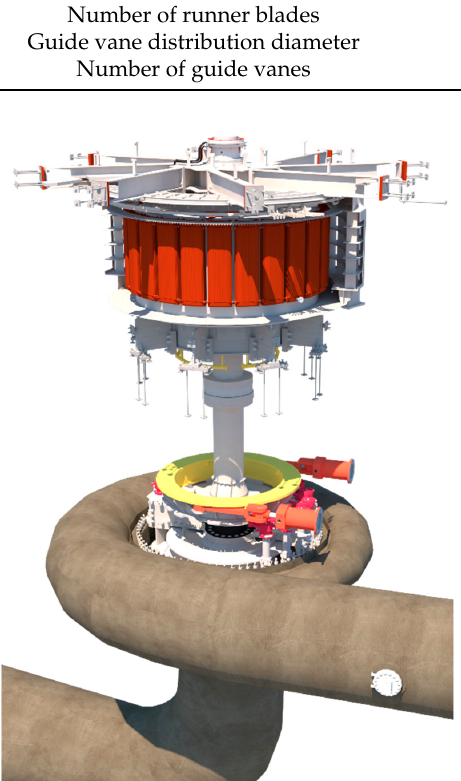
Figure 6. The basic structure of the FTU.